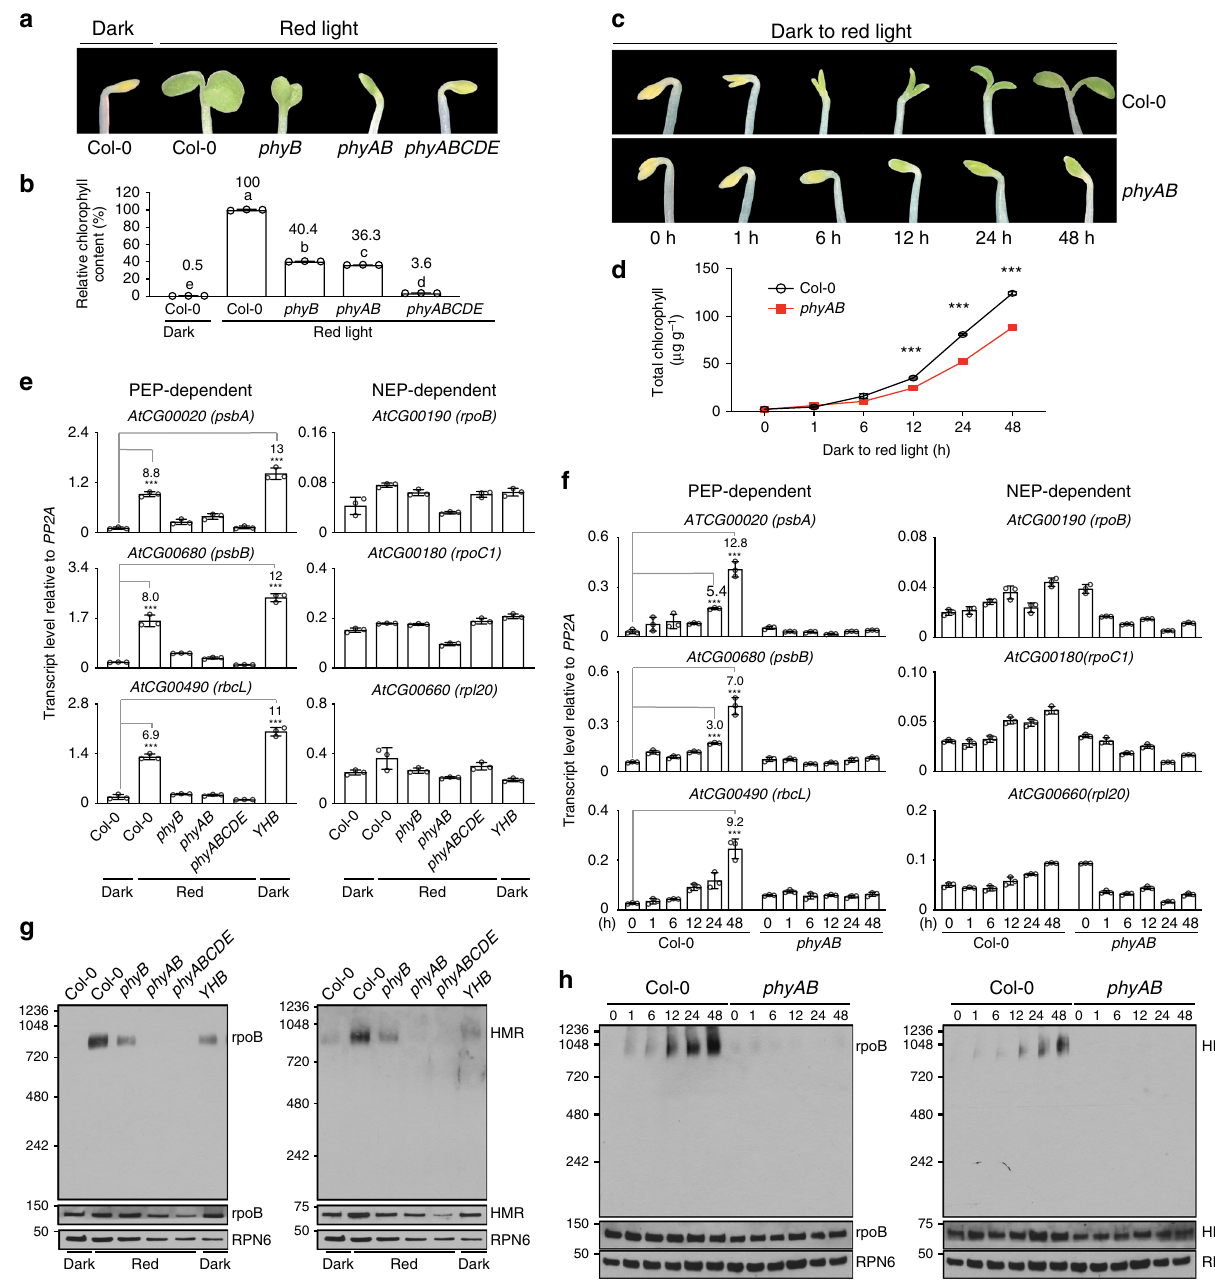
Fig. 1 Phytochromes activate PhAPG s by promoting the assembly of the PEP. a Images of embryonic leaves from 4-d-old Col-0, phyB-9 ( phyB ), phyA-211/ phyB-9 ( phyAB ), and phyA/phyB/phyC/phyD/phyE ( phyABCDE ) seedlings grown in either darkness or 10 μ mol m − 2 s − 1 R light. b Total chlorophyll levels in seedlings shown in ( a ). Different letters denote statistically signi fi cant differences in chlorophyll content (ANOVA, Tukey ’ s HSD, p ≤ 0.001). c Images of embryonic leaves of 4-d-old Col-0 and phyAB seedlings from the indicated time points after dark-grown seedlings were illuminated with 10 μ mol m − 2 s − 1 R light. d Total chlorophyll levels in Col-0 and phyAB seedlings during the dark-to-light transition described in ( c ). *** Indicates a statistically signi fi cant difference between Col-0 and phyAB (Student ’ s t -test, p ≤ 0.001). e , f qRT-PCR results showing the transcript levels of representative PEP- and NEP- dependent genes in 4-d-old indicated lines grown in either darkness or 10 μ mol m − 2 s − 1 R light ( e ) or during the dark-to-light transition described in ( c ) ( f ). The transcript levels were calculated relative to those of PP2A . Fold changes are shown only for the samples exhibiting greater than twofold changes compared with the values of dark-grown Col-0 (***, Student ’ s t -test, p ≤ 0.001). g , h Immunoblots showing the levels of the PEP complex as well as rpoB and HMR proteins in 4-d-old indicated lines ( g ) or during the dark-to-light transition ( h ). Total protein was isolated under either native or denaturing conditions and resolved by blue-native PAGE or SDS-PAGE, respectively. PEP complex on blue-native gels and denatured rpoB and HMR separated by SDS- PAGE were detected by immunoblots using antibodies against rpoB and HMR. RPN6 was used as a loading control. For ( b ), ( c ), ( e ), and ( f ), error bars represent SD of three biological replicates. The source data underlying the chlorophyll measurements in ( b ) and ( d ), the qRT-PCR analysis in ( e ) and ( f ), and immunoblots in ( g ) and ( h ) are provided in the Source Data fi le